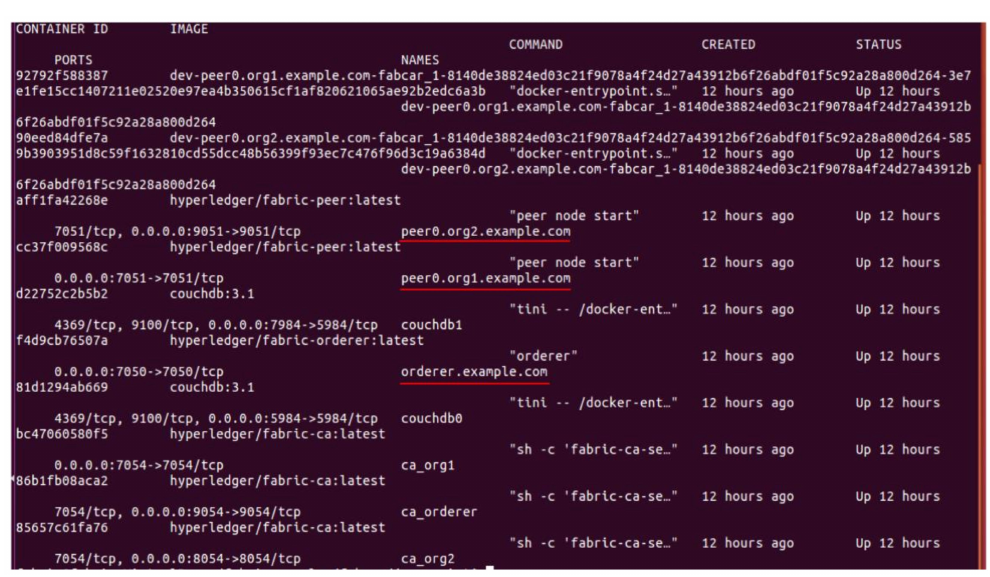
Figure 8. The generated fabric network based on the test-network.